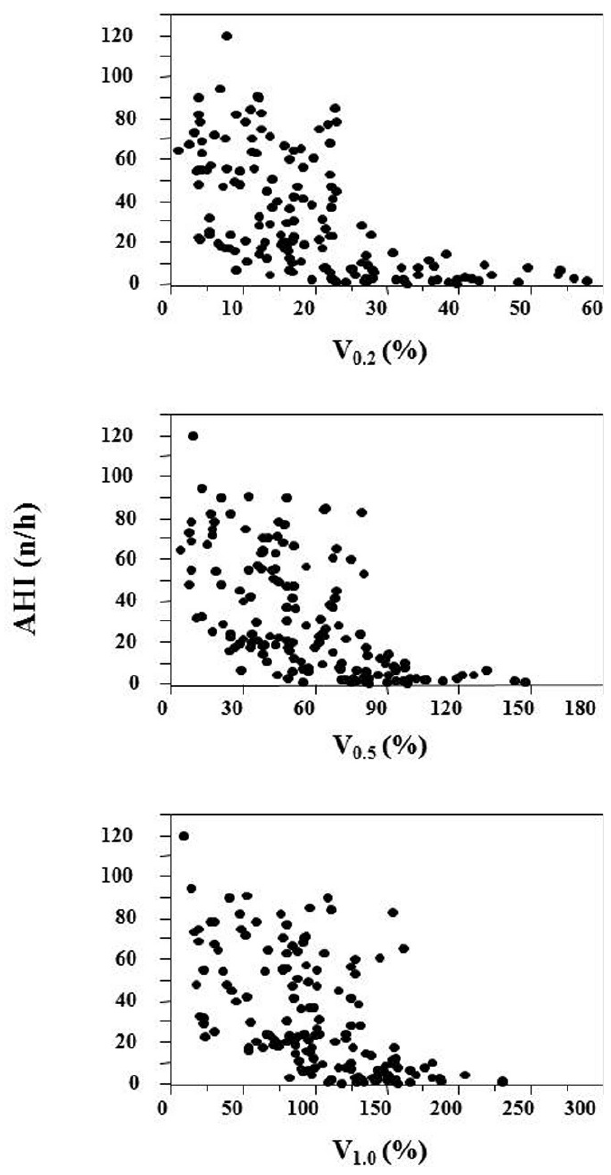
Figure 2 - The relationships between AHI and V 0.2 (%), V 0.5 (%), and V